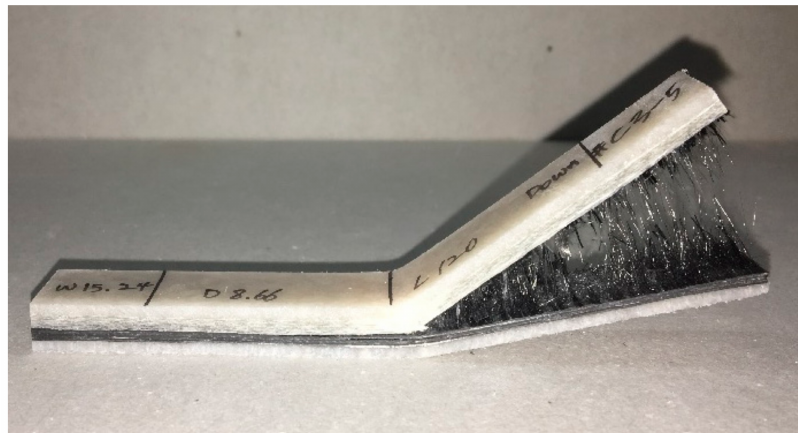
Figure 6. Carbon Fiber Fracture and